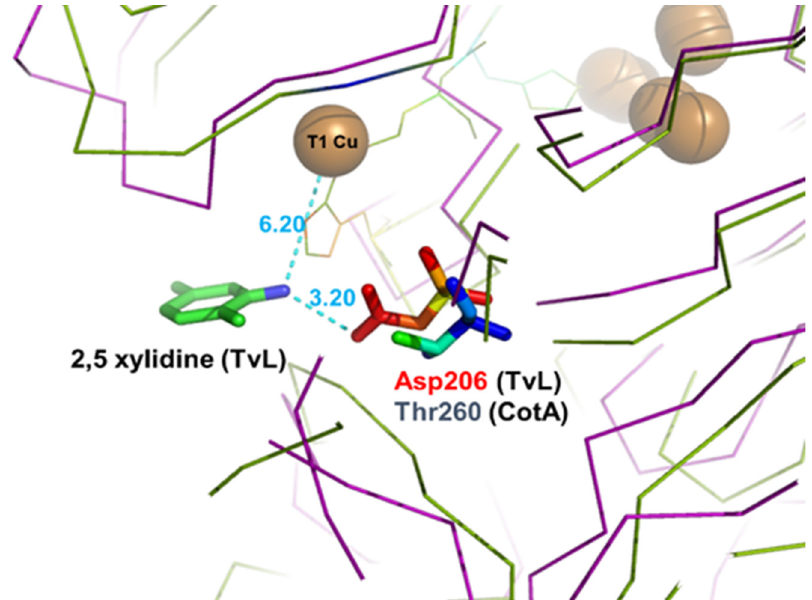
Figure 2. Overlap of the active site of the fungal TvL and bacterial CotA laccases with detail on the Asp206/Thr260. Pictures drawn with the use of PyMOL software and supported PDB1w6l and 1KYA. It is believed that carboxylate residues are crucial to oxidise substrates containing phenolic or aromatic amine functional groups aiding in the deprotonation of substrates.